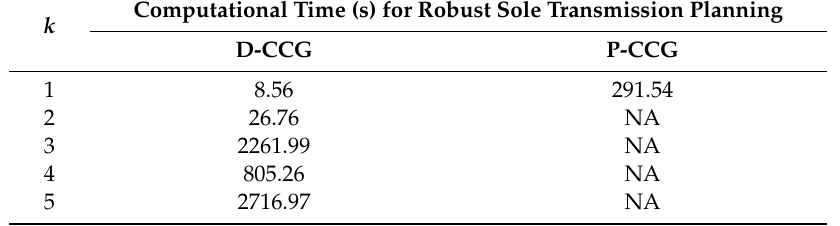
Table 9. Computation time of D-CCG and P-CCG for the IEEE 118-Bus Power System under di ff erent k